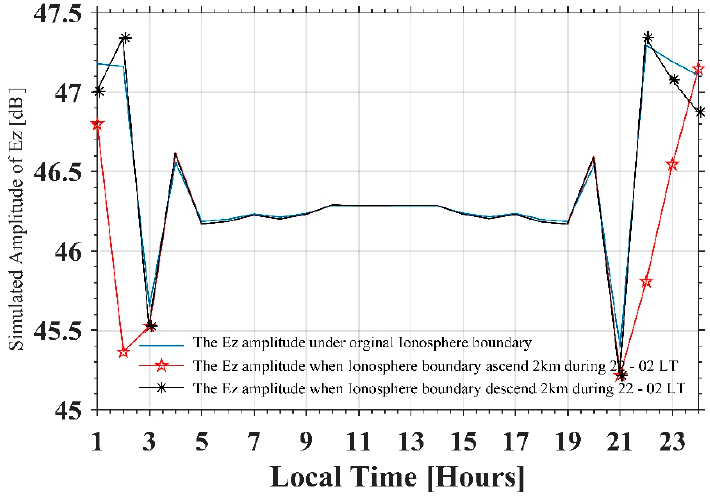
Figure 10. The simulated Ez amplitude under three different bottom heights of ionosphere during 22-02 LT. The blue solid line represents the Ez amplitude under the original IRI profile (bottom height of the ionosphere is 80 km), the red solid line with pentagrams represents the Ez amplitude when the bottom height of the ionosphere ascends to 82 km, the blue solid line with asterisks represents the Ez amplitude when the bottom height of the ionosphere descends to 78 km.